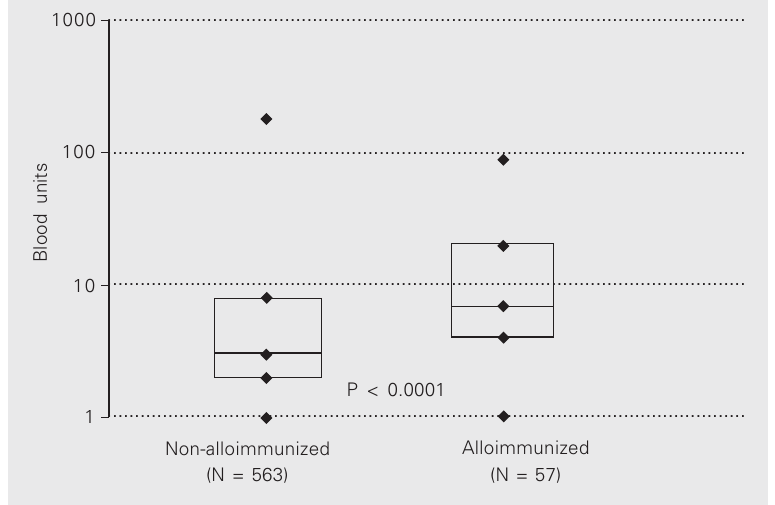
Figure 1. Number of transfusions received by alloimmunized and non-alloimmunized patients with sickle cell disease. Higher to lower, the points indicate maximum number, 75th percentile, median, 25th percentile, and minimum number of transfusions (logarith- mic scale).